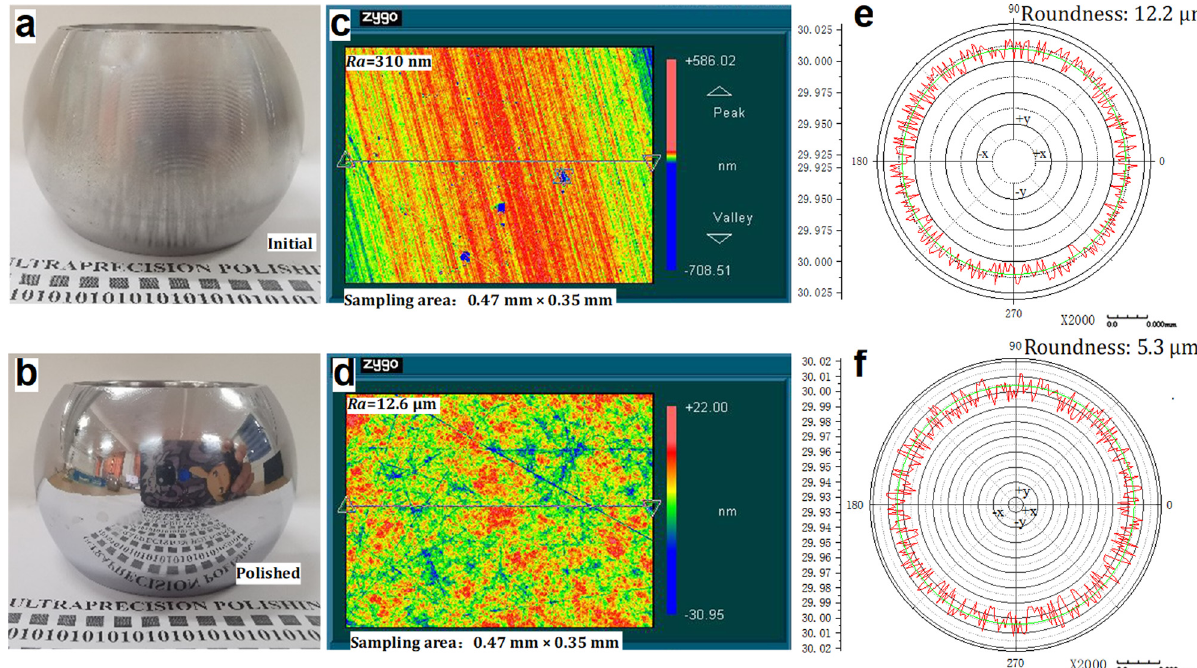
Figure 8: Comparison of the initial and polished surface quality: ( a ) initial work piece; ( b ) polished work piece ( 2.5 h ) ; ( c ) initial surface with scratches; ( d ) polished work piece ( 2.5 h ) ; ( e ) roundness of the initial work piece; and ( f ) roundness of the polished work piece ( 2.5 h )